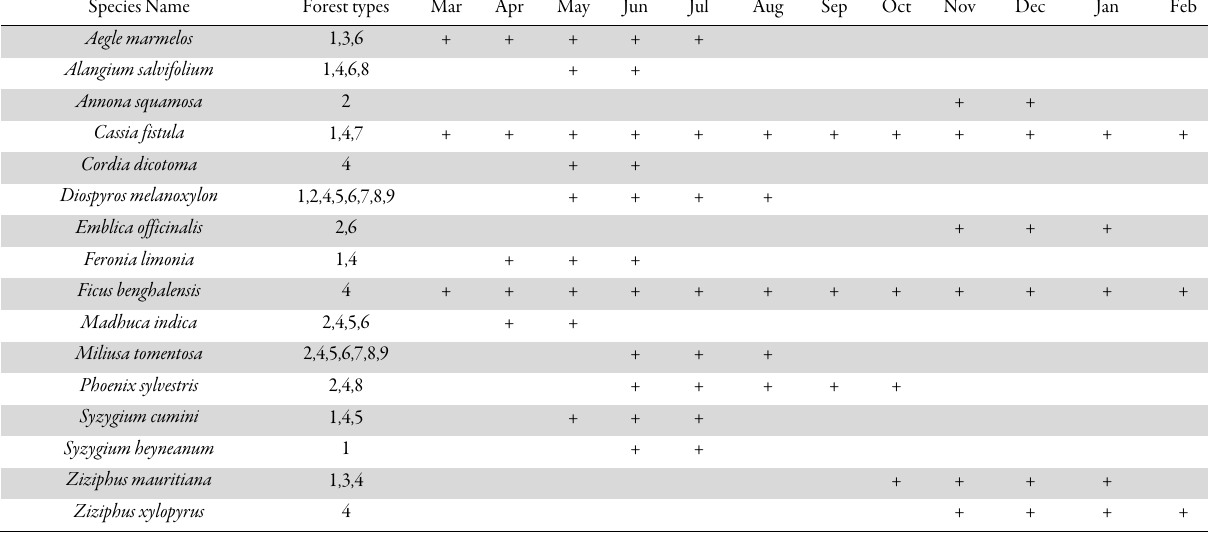
Table 4. List of food plants available in different forest types of study area (1- Acacia tortilis scrub forest, 2- Diospyros and Butea mixed forest, 3- Acacia catechu and Acacia tortilis forest, 4-Mixed Forest, 5-Riverine forest, 6-teak and Miliusa mixed forest, 7- Wrightia and Butea forest, 8- Wrightia and Diospyros mixed forest, 9- Wrightia and Miliusa mixed forest) Species